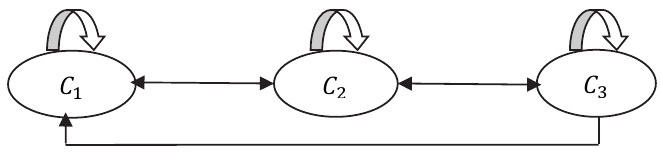
Fig. 3. The affiliation communication among evaluation criteria.